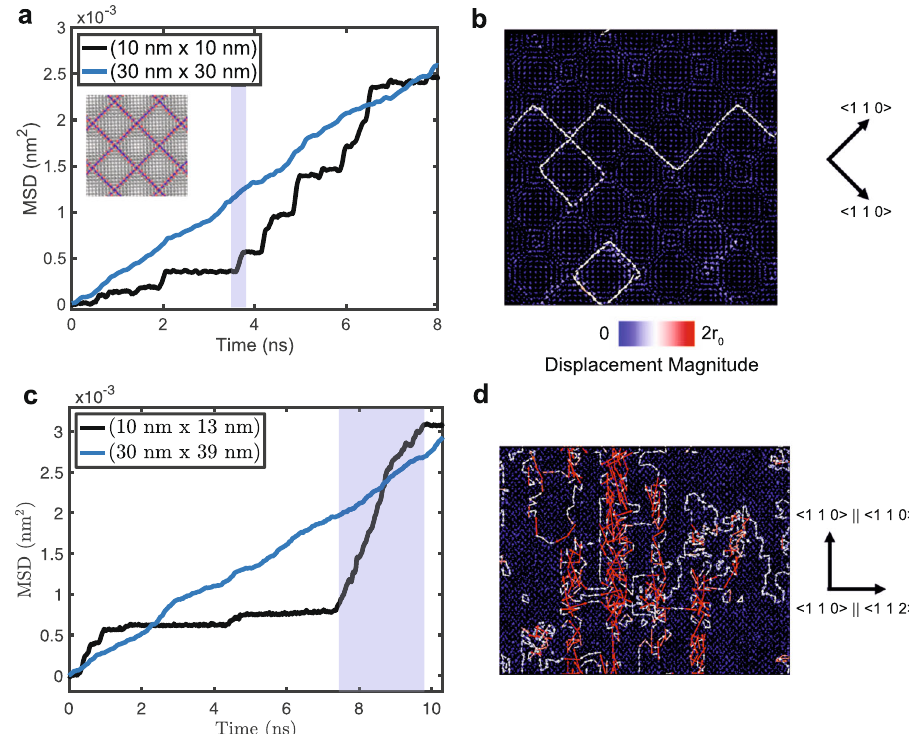
Fig. 6 Avalanche-like diffusion behavior for various GB types. Intermittent diffusion behavior in the a , b Σ 85{100} low-angle twist GB at 500 K and c , d {100} ∣∣ {111} HAIC GB at 700 K. The twist GB is composed of a square network of dislocations displayed in the top left corner of the MSD plot. Panels ( b ) and ( d ) are atomic displacement maps using the same color coding as in Fig. 3 and representing the avalanches shown as blue highlighted regions in ( a ) and ( c ). In ( b ), the GB structure constrains the collective atomic displacements to the dislocation cores, resulting in string-like and ring-like